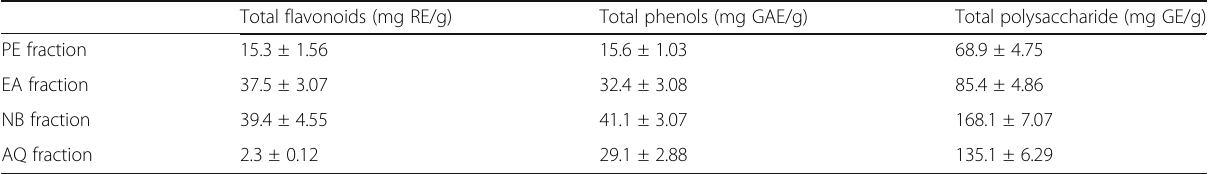
Table 1 Amounts of total flavonoids, phenols and polysaccharides in each fraction isolated from ethanol extract of Lysimachia christinae